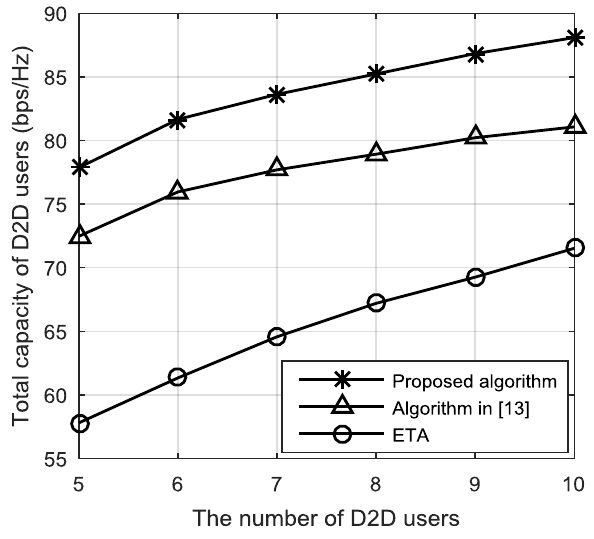
Figure 4. Total capacity of D2D users with different number of D2D users.